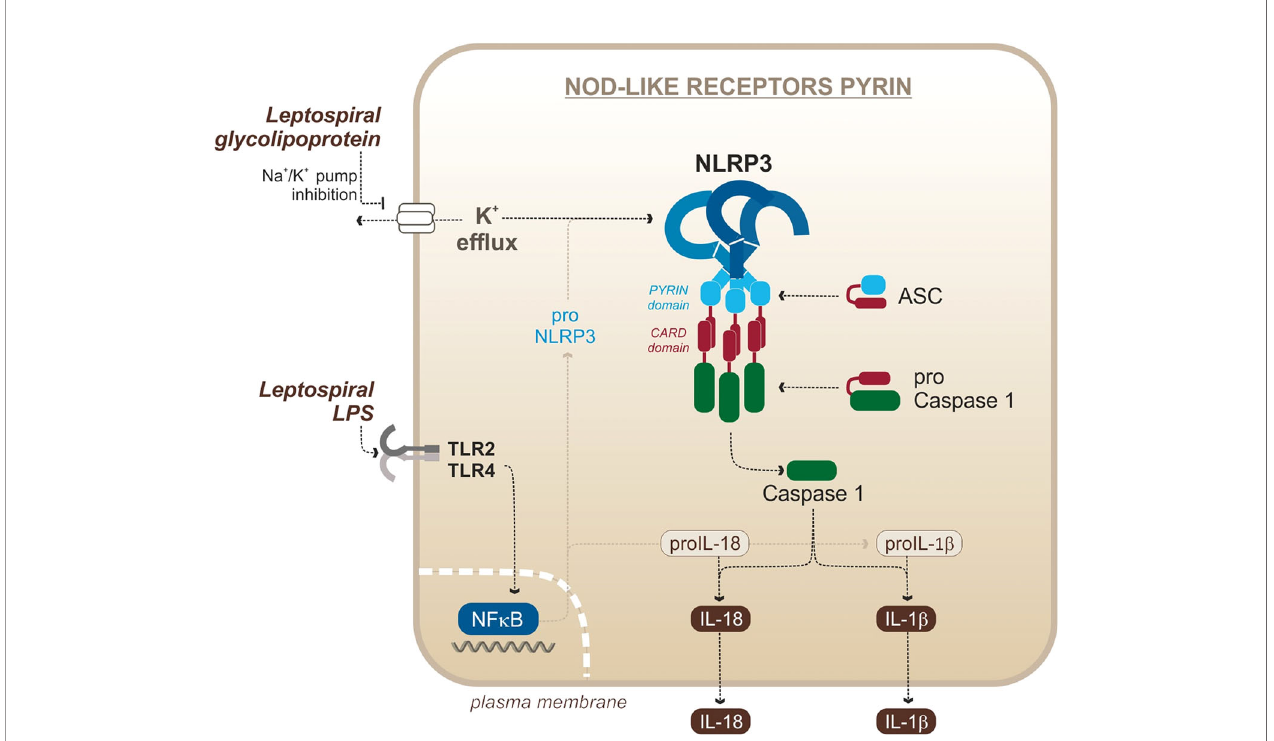
FIGURE 4 | Leptospiral activation of the murine NLRP3 canonical in fl ammasome. Adapted from Lacroix-Lamande et al.